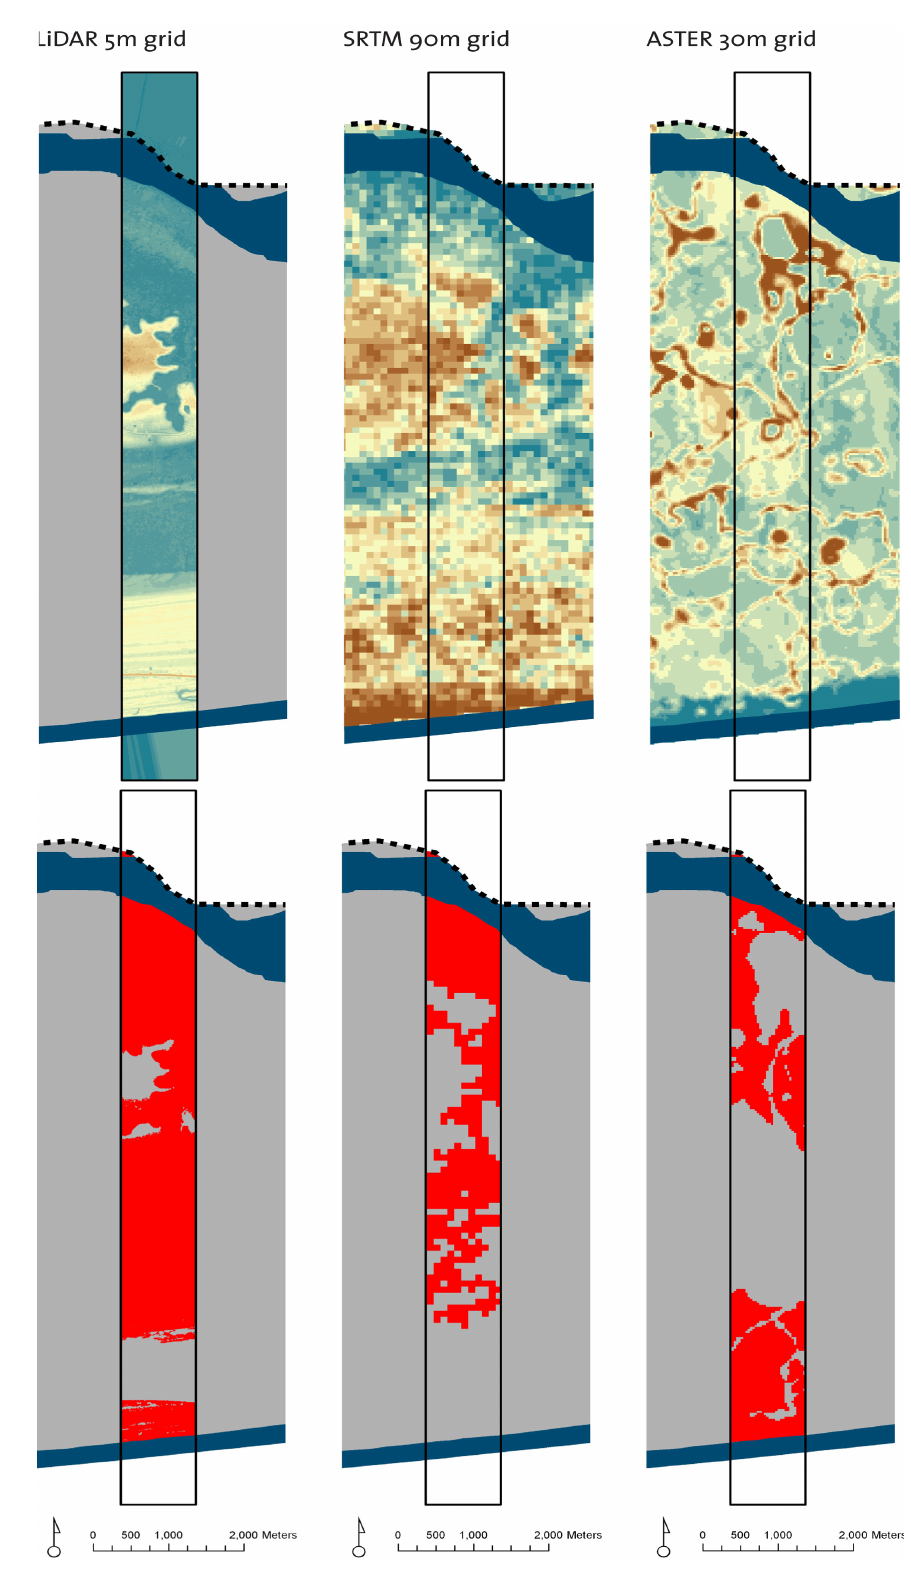
Figure 6. Terrain elevation (upper image; the more brownish, the higher the elevation) and LECZ area (lower image, LECZ indicated in red) for one of the